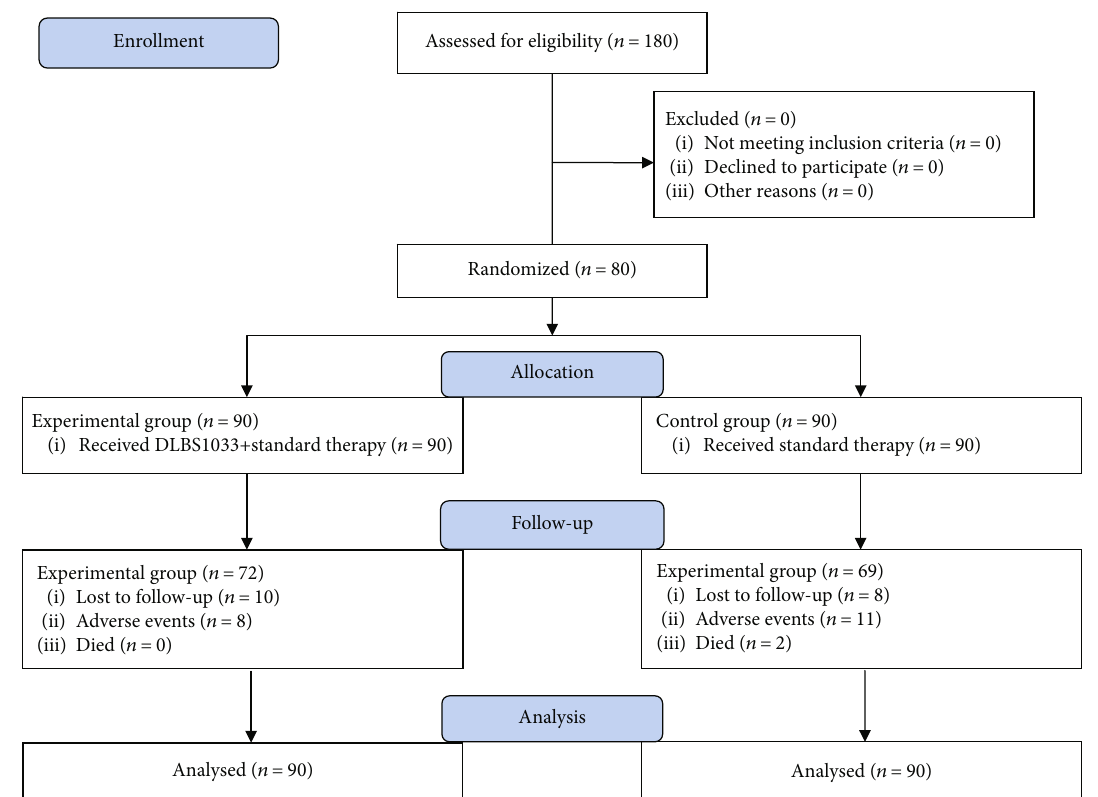
Figure 1: CONSORT fl ow chart of the